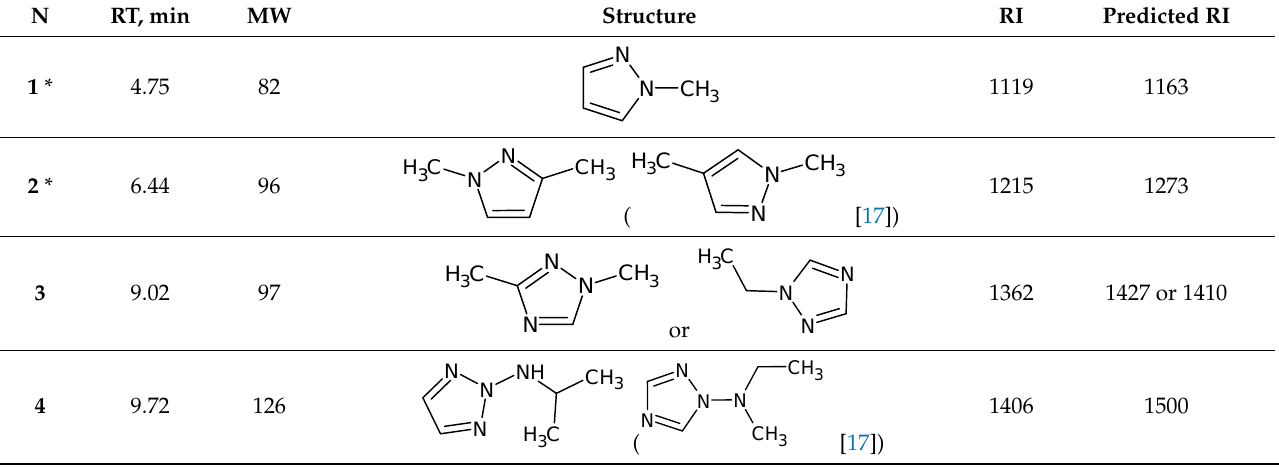
Figure 4. Mass chromatogram (gas chromatography and total ion current) of the considered mixture, registered using the polar stationary phase. Peaks are signed according to the compound numbers listed in Tables 2 and 3. Table 2. Proposed structures of detected transformation products of unsymmetrical dimethylhydrazine.